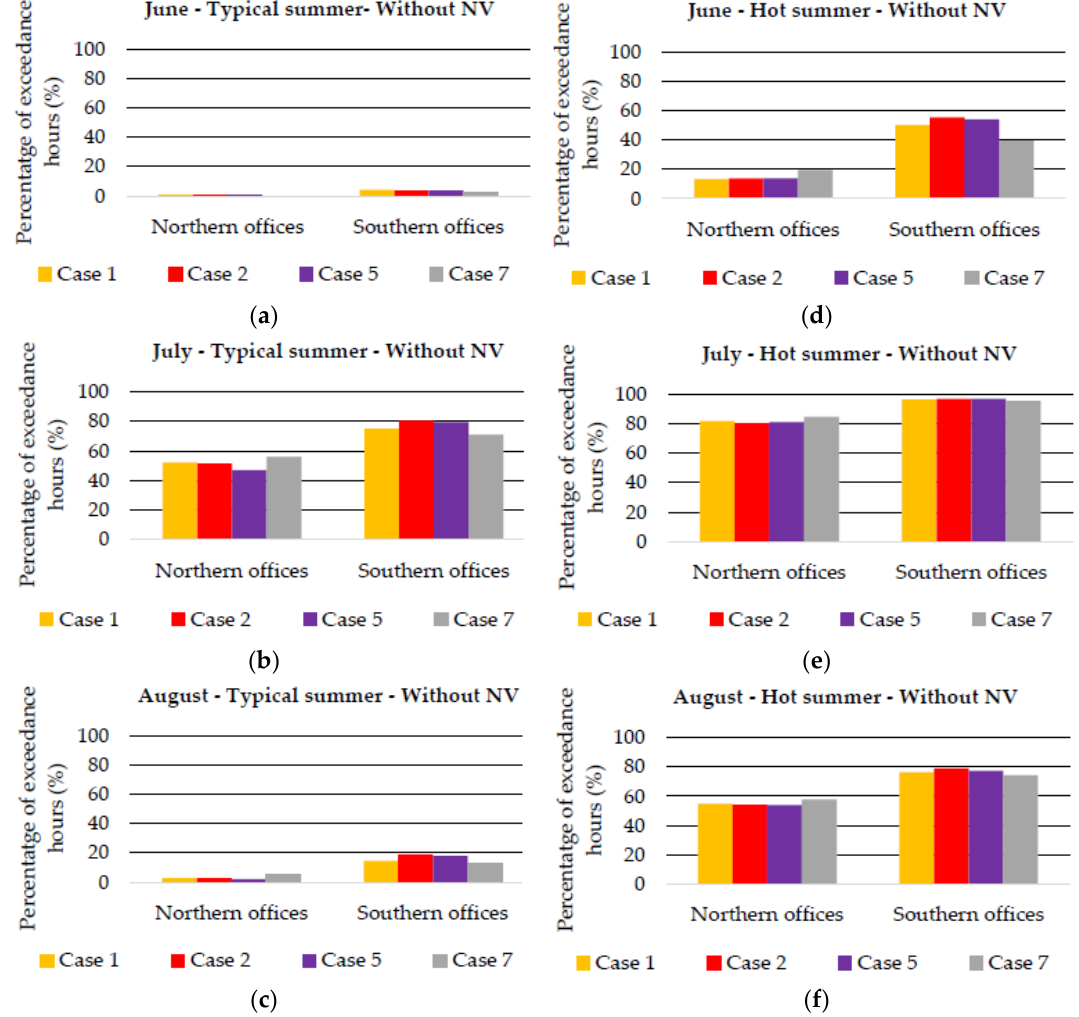
Figure 7. Percentage of exceedance hours in offices for cases without NV during June, July and August during ( a – c ) the typical summer and ( d – f ) the hot summer of 2018. Case 1: All doors always closed, Case 2: Northern offices’ doors always closed/Southern offices’ doors open during working hours, Case 5: Northern offices’ doors always closed/Southern offices’ doors always open, Case 7: All doors always open. Southern offices represent offices with southeast orientation with higher internal solar gains compared to other offices. Northern offices represent all other offices excluding the open-plan office.